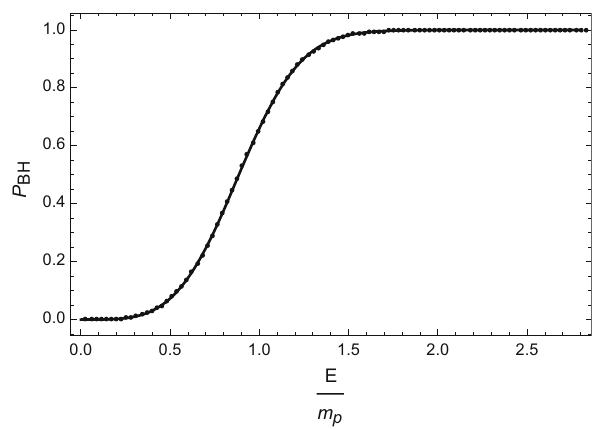
Fig. 5 Probability for the system of two shells that collide at R = 0 to form a black hole as a function of the total energy E (in units of Planck mass)